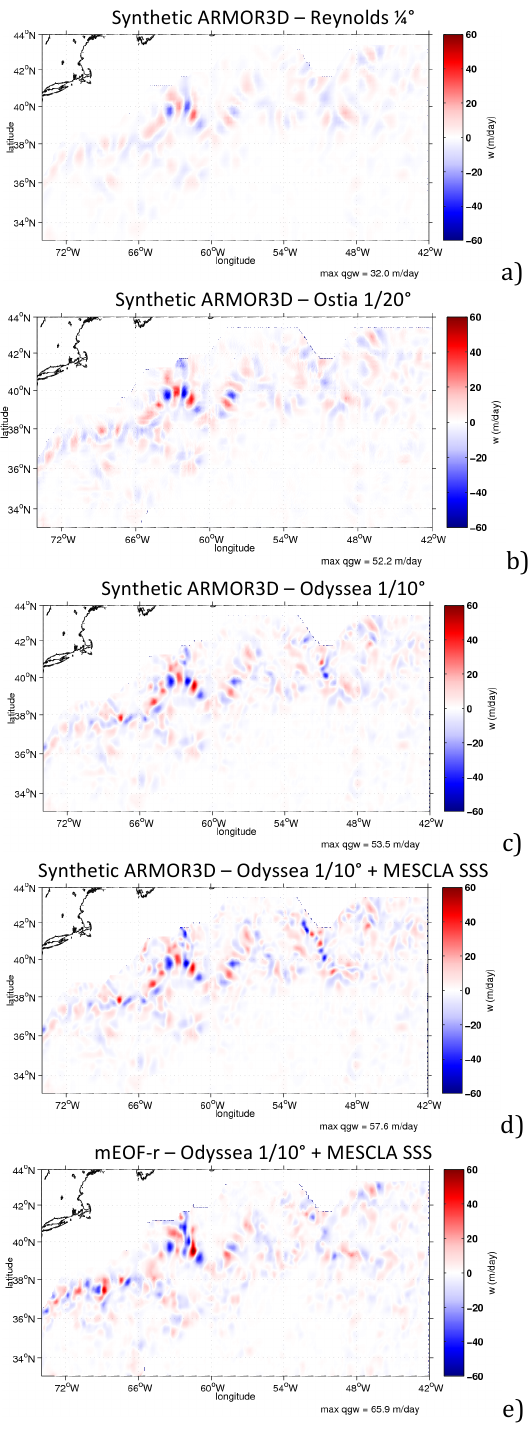
Fig. 13. QG vertical velocity fields at 100m as retrieved from the temperature and salinity fields reconstructed through the selected methods: (a) ARMOR3D using Reynolds L4 SST as input, (b) ARMOR3D using OSTIA L4 SST as input, (c) AR- MOR3D using ODYSSEA L4 SST as input, (d) ARMOR3D using ODYSSEA L4 SST andMESCLASSSasinput,and (e) mEOF-r( T - S -SH) SSS-SSH forthesalinityfieldand mEOF-r( T - S -SH) SST-SSH for the temperature.